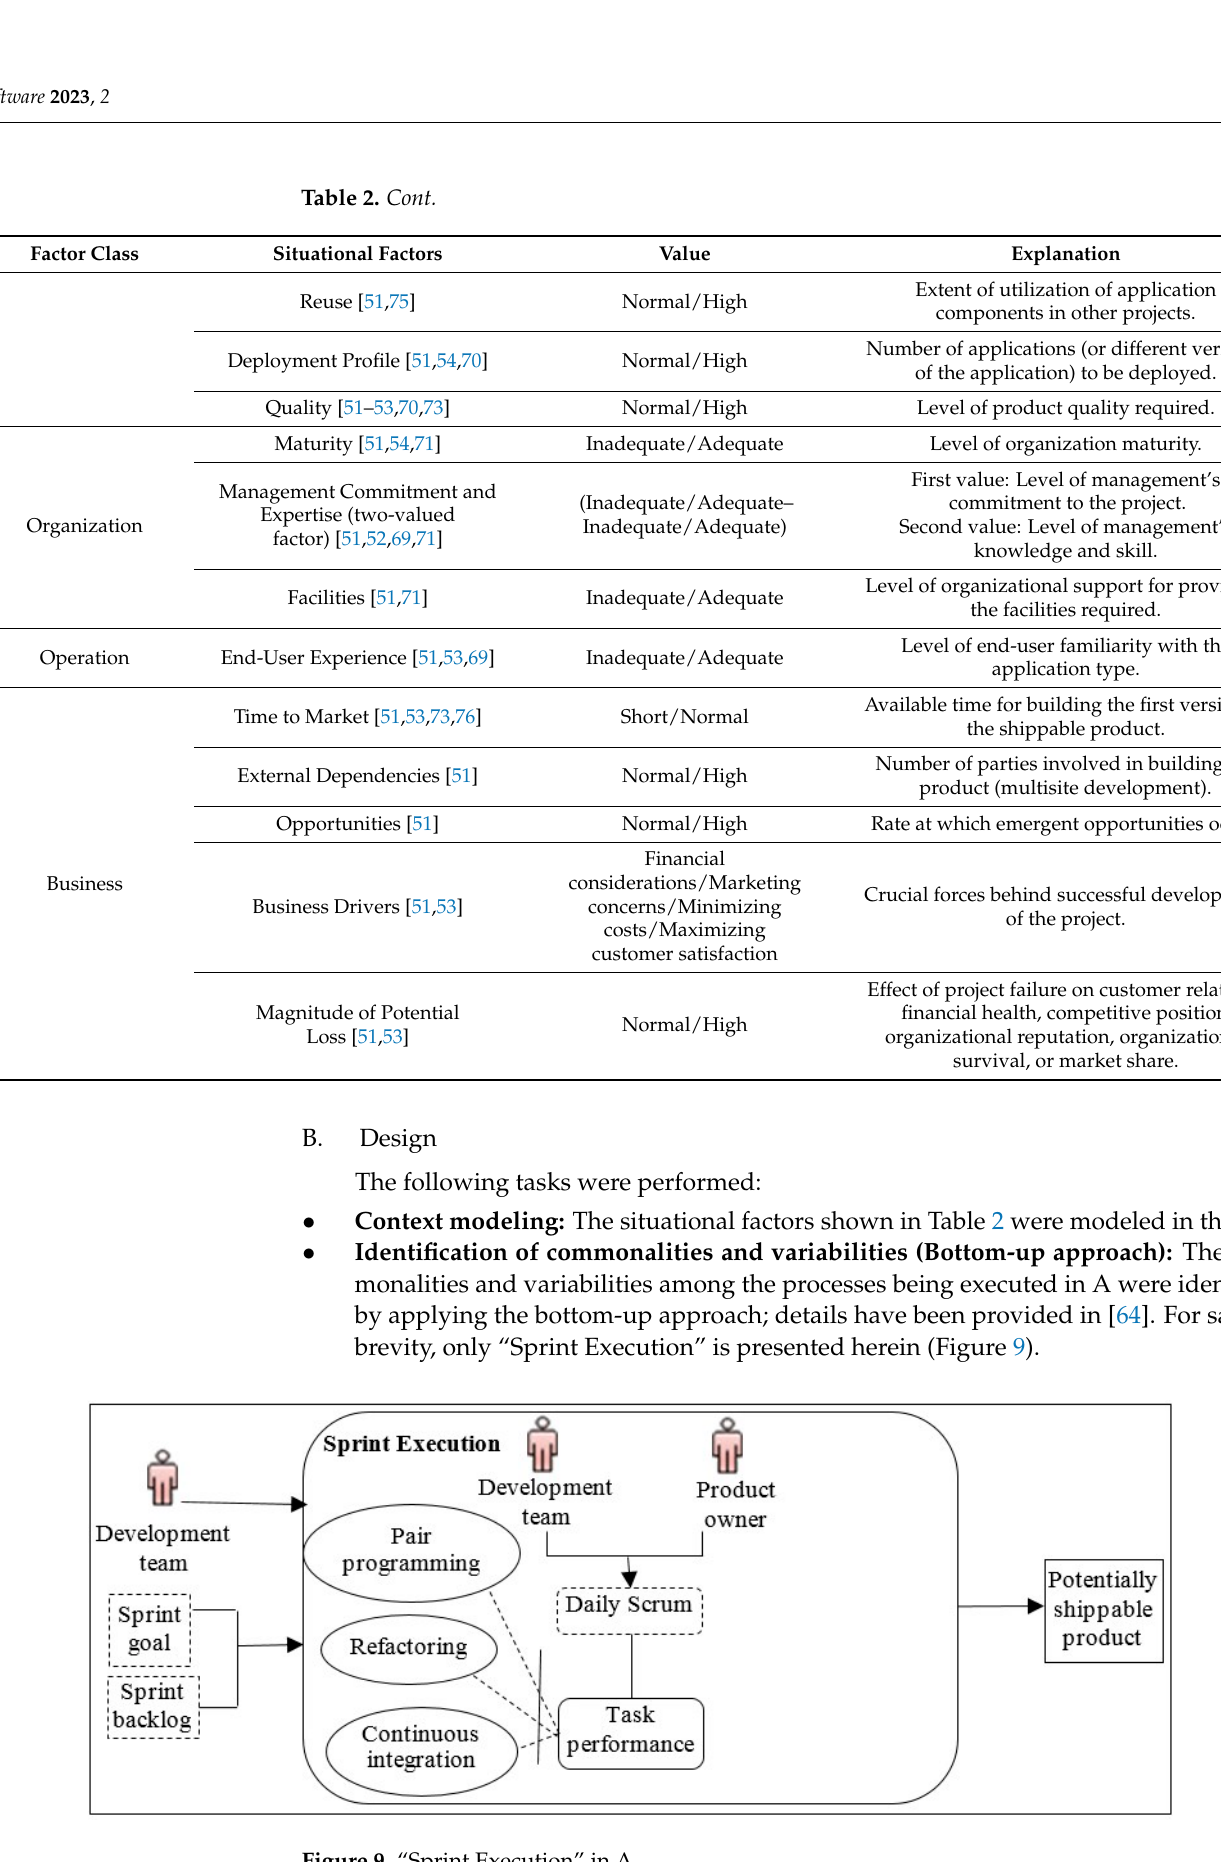
Figure 9. “Sprint Execution” in A.